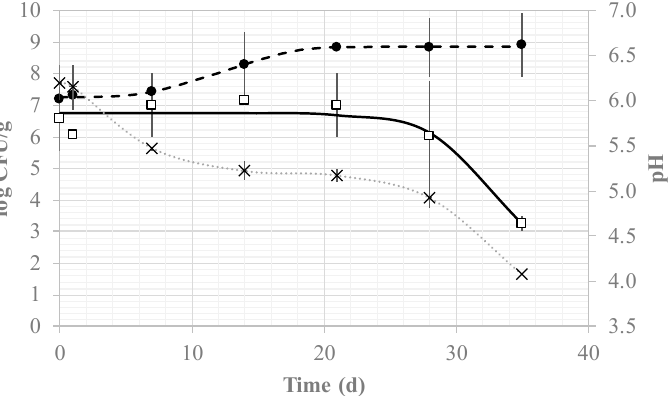
Figure 3. Total bacterial counts, S. aureus survival and pH evolution during Domiati cheese ripening for 35 d storage in control samples. ● Observed growth of total bacterial counts (dashed line corresponds to the fitted Baranyi model); □ Observed survival of S. aureus (solid line corresponds to the fitted Weibull model); × pH evolution.